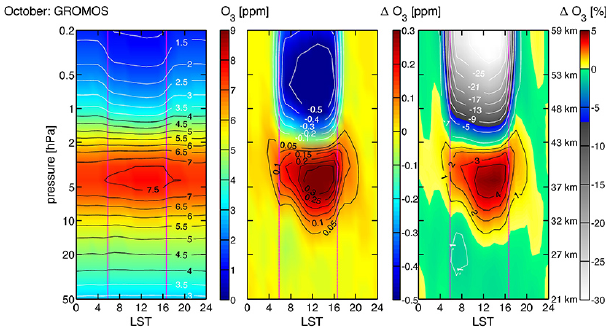
Figure 4d. Same as Fig. 4a but for the month of